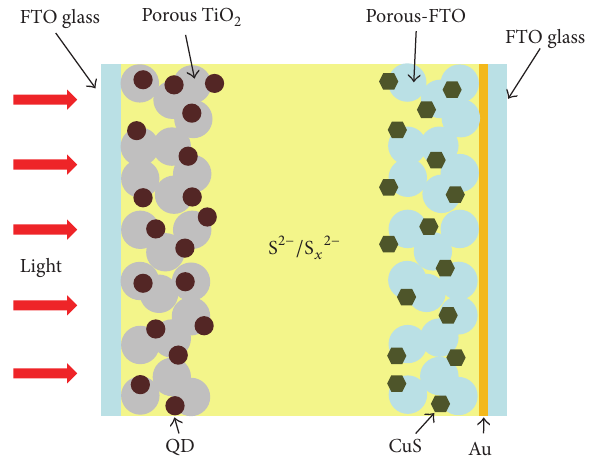
Figure 1: Schematic illustration of a QDSSC equipped with a porous-FTO/CuS counter electrode.